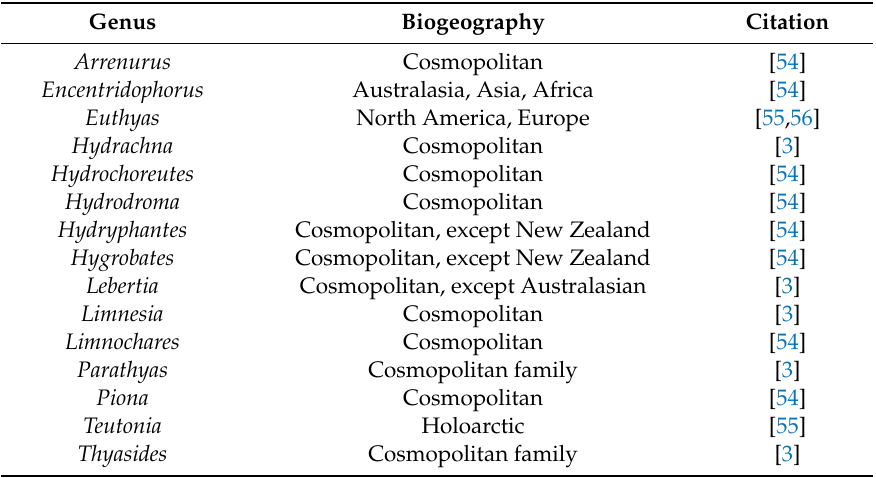
Table 5. Biogeography of water mite